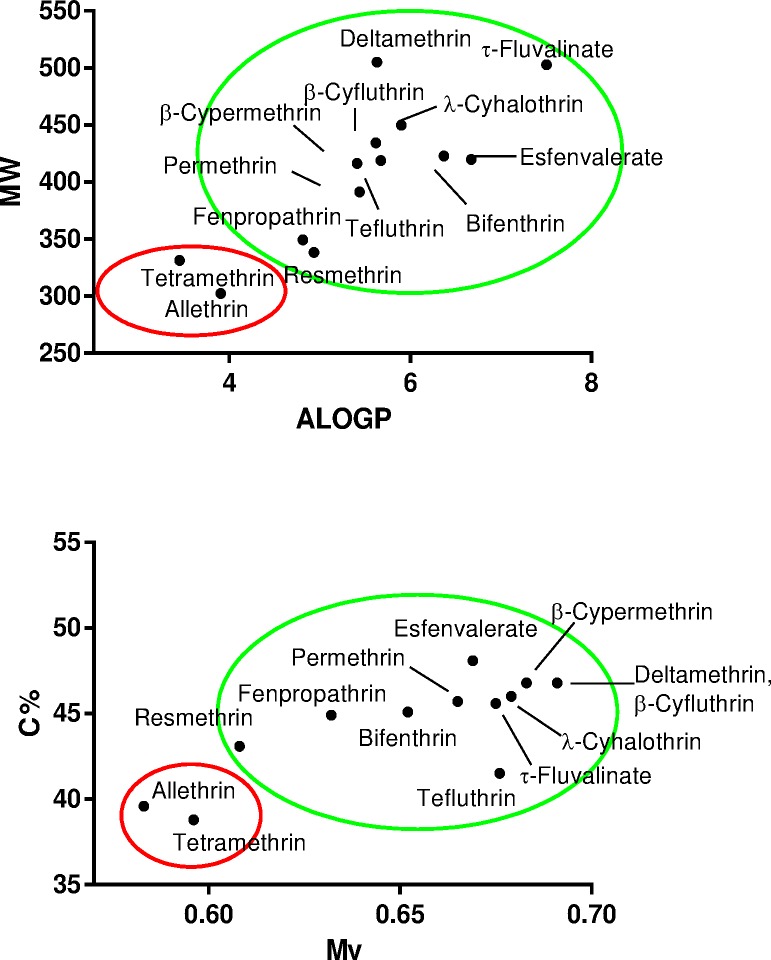
Graphical pairwise representation of some molecular descriptors allowing to discriminate allethrin/tetramethrin from other pyrethoids.Allethrin/tetramethrin are graphically included in a red circle, whereas other pyrethoids are included in a green circle. MW, molecular weight; ALOGP, Ghose-Crippen-Viswanadhan octanol-water partition coefficient; Mv, mean atomic van der Waals volume (scaled on Carbon atom); C%, percentage of C atoms.